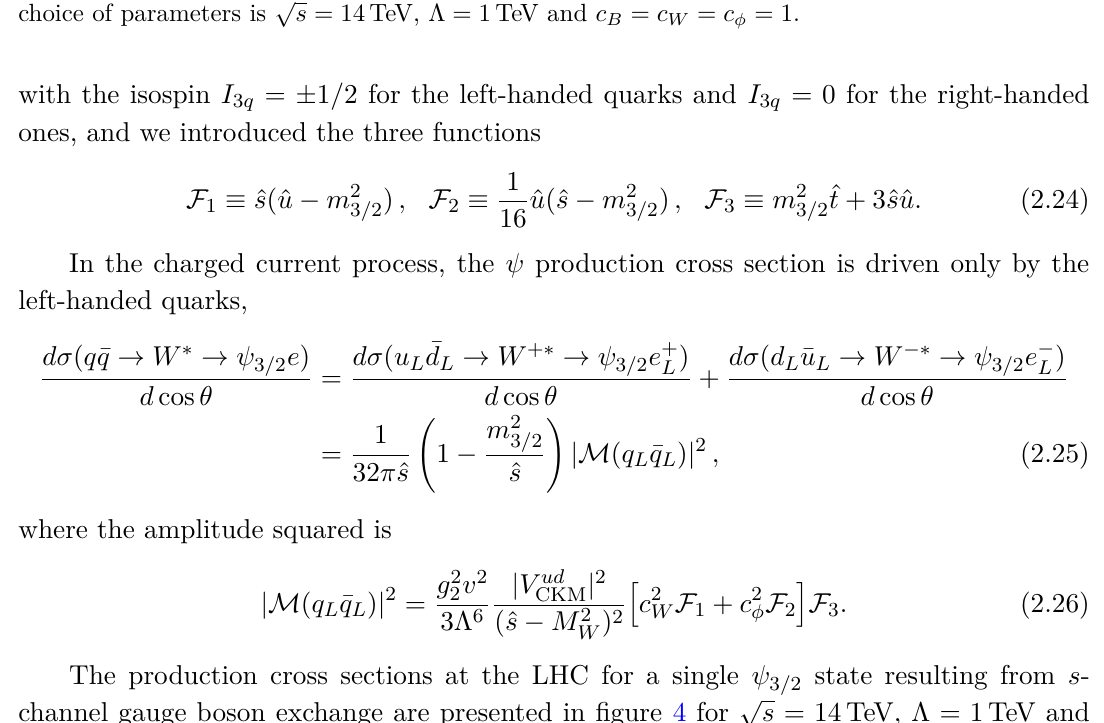
Figure 4 . The production cross sections of ψ particles at the LHC as a function m 3 / 2 the processes pp → ψ ν + X and pp → ψ e + X , corresponding to the parton level processes 3 / 2 3 / 2 q ¯ q → γ ∗ , Z ∗ → ψ ν and q ¯ q → W ∗ → ψ e given at eqs. (2.21) and (2.25) respectively. The 3 / 2 3 / 2 √ choice of parameters is s = 14 TeV, Λ = 1 TeV and c B = c W = c φ = 1